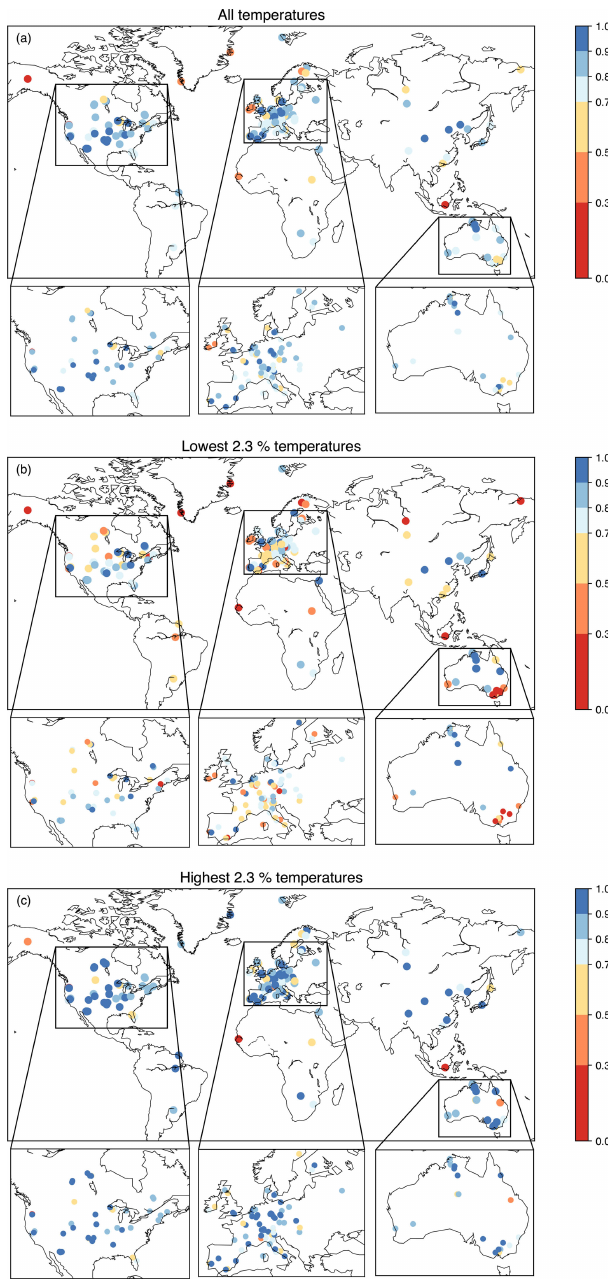
Figure 2. Maps of Q le measurement ratios. Panel (a) shows the Q le measurement ratios for the overall temperature distribution, panel (b) shows them for the lower extreme and (c) for the upper extreme. Each dot on the map represents a flux tower site.